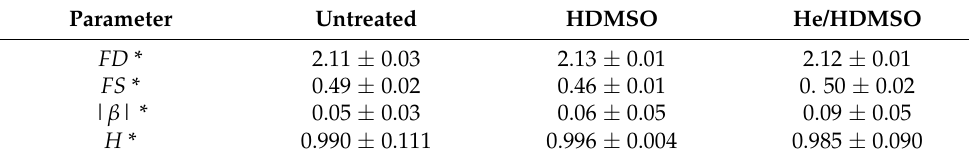
Table 4. Advanced fractal parameters of the untreated and treated starch films.